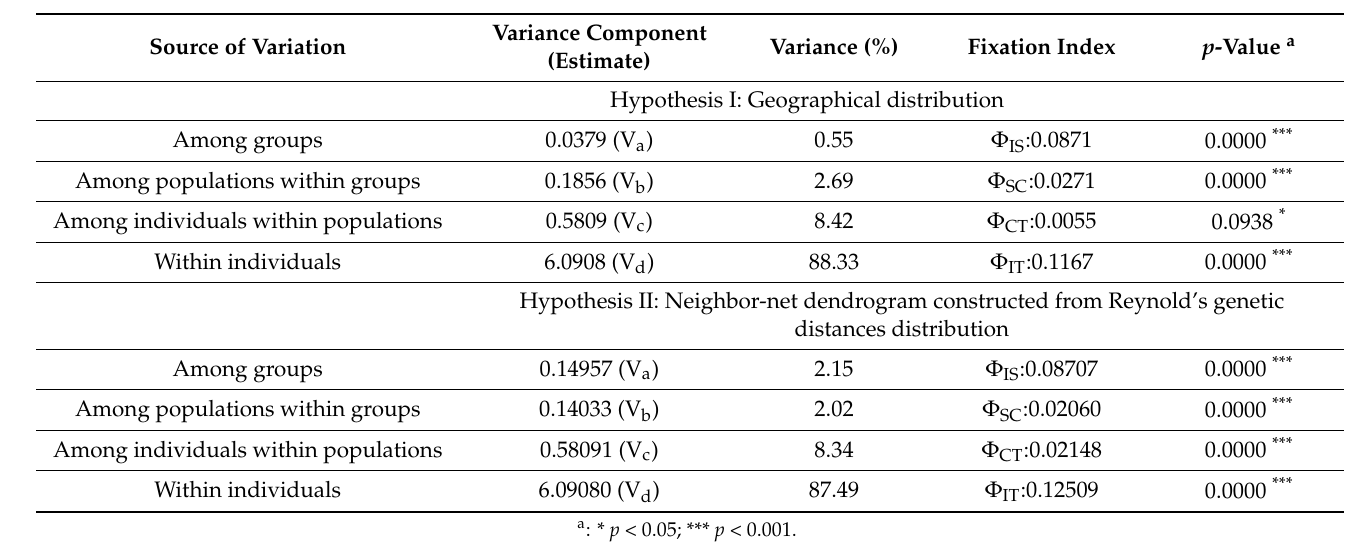
Figure 2. Neighbor-net dendrogram constructed from Reynold’s genetic distances among 17 Turkish water buffalo populations. I Cluster I; II Cluster II; Marmara Region (MRM): ˙Istanbul/Çatalca-IST; Tekirda˘g/Saray-TEK; Balıkesir-BAL; Bursa-BUR; Black Sea Region (BSR): Düzce-DUZ; Giresun-GIR; Amasya-AMS; Tokat-TOK; Çorum-COR; Sinop-SIN; Samsun- SAM; Aegean Region (AER): Afyon-AFY; Central Anatolian Region (CAR): Kayseri (KAY), Sivas-SVS; Eastern Anatolia Region (EAR): Mu¸s-MUS, Bitlis-BIT; Southeast Anatolian Region (SAR): Diyarbakır-DYB. Table 2. Analysis of molecular variance (AMOVA) results for 17 populations of Turkish buffalo based on 20 microsatellite data, using the ARLEQUIN